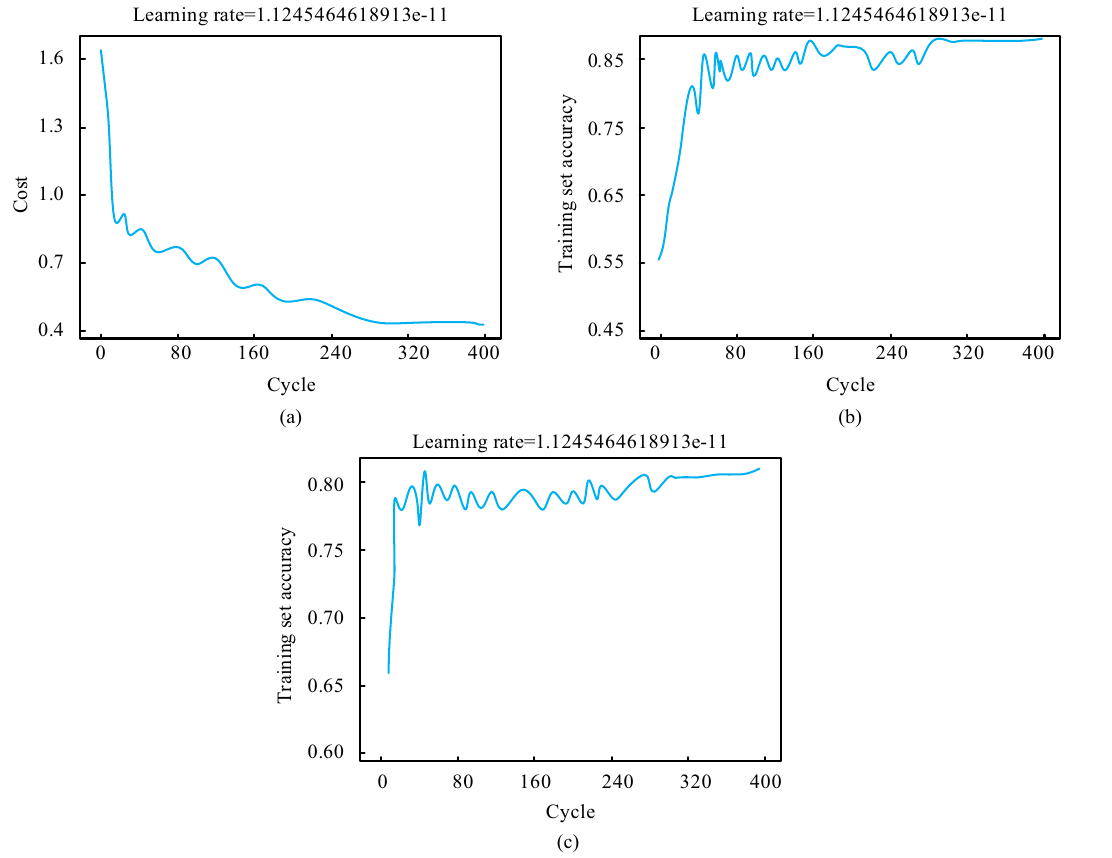
Figure 9: Cost and accuracy of encrypted datasets ( absolute value ) : ( a ) cost, ( b ) training set accuracy, and ( c ) validation set